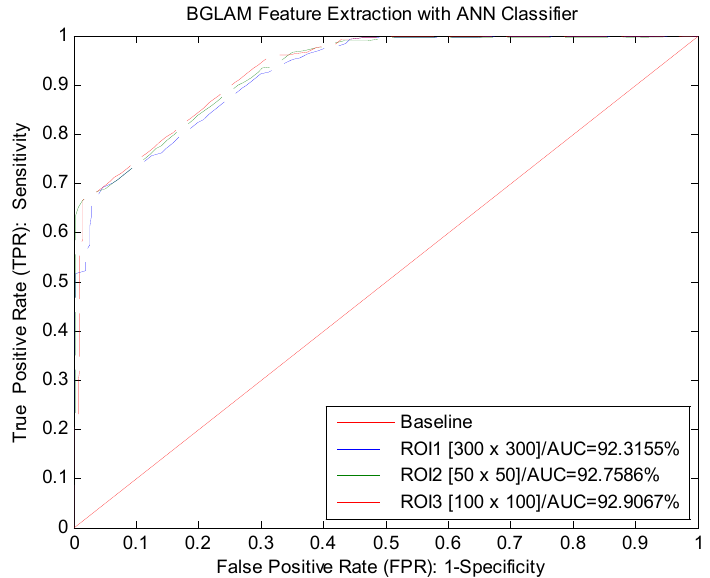
Figure 16. Oil palm FFB type classification based on BGLAM and ANN classifier.